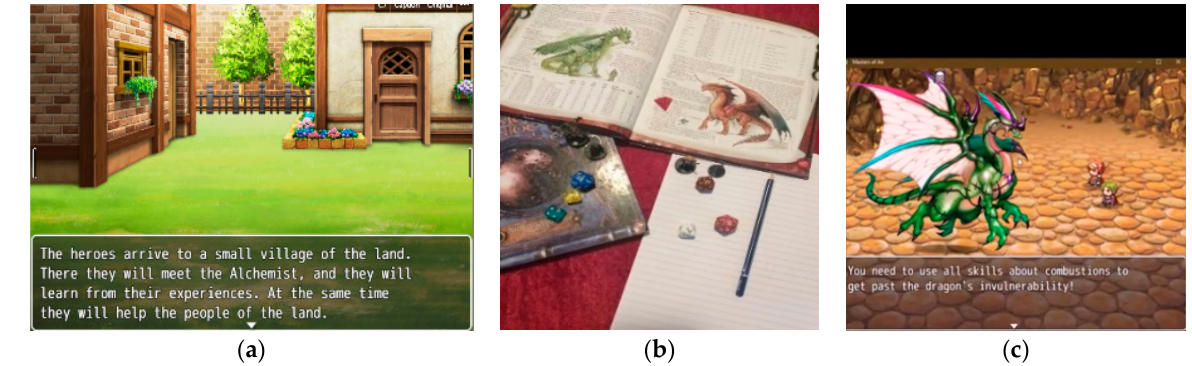
Figure 1. Narrative element is used to motivate players in the game ( a ) Adventure games rely on a structured and guided narrative ( b ) Tabletop role-playing games (RPGs) are more a social affair, creating stories that can be emotionally powerful and personally meaningful ( c ) Digital RPG narrative is flexible as Playable Characters need to grow in order to overcome obstacles and to advance the game plot.